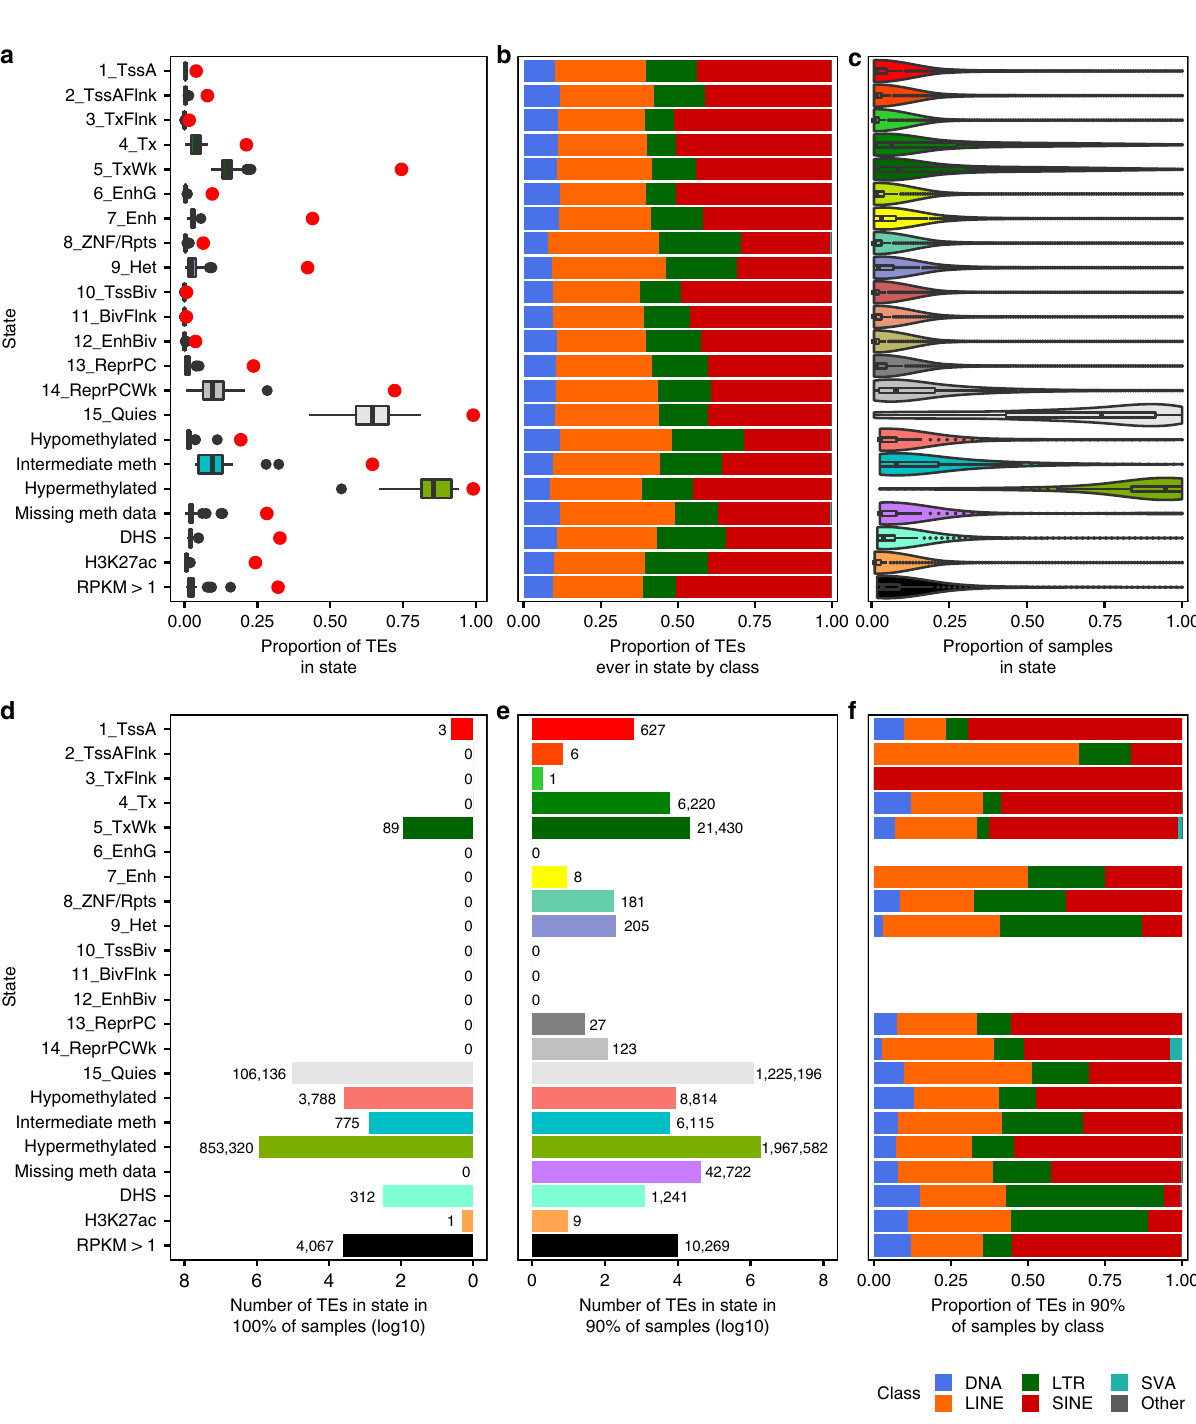
Fig. 2 Individual TE potential to be annotated with an epigenetic state. a Boxplots indicate the proportion of all TEs (4,430,788 TEs) annotated with the state per epigenome (chromHMM states n = 127 epigenomes, methylation states n = 37, DHS n = 53, H3K27ac n = 98, expression RPKM >1 n = 56; see Methods). Red dots are the fraction of TEs annotated with the state in at least one epigenome. For WGBS states, only TEs with CpGs are included (3,200,428 TEs, 72% of all TEs). b For TEs annotated with the state in at least one epigenome ( a , red dots), the proportion in each TE class. The color legend is located below f . c For TEs annotated with the state in at least one epigenome ( a , red dots), the proportion of all Roadmap epigenomes the TE is annotated with the state. The b and c y -axes are shared with a . d Number of TEs annotated with the state in 100% of epigenomes. e Number of TEs annotated with the state in ≥ 90% of epigenomes. f For TEs annotated with the state in ≥ 90% of epigenomes, the proportion in each TE class. The e and f y -axes are shared with d . a , c – e Boxplots, bars, and distributions are colored by state ( y -axis). a , c Boxplot elements: center line, median; box limits, fi rst and third quartiles; whiskers, maximum value ≤ 1.5*IQR from box limits; points,